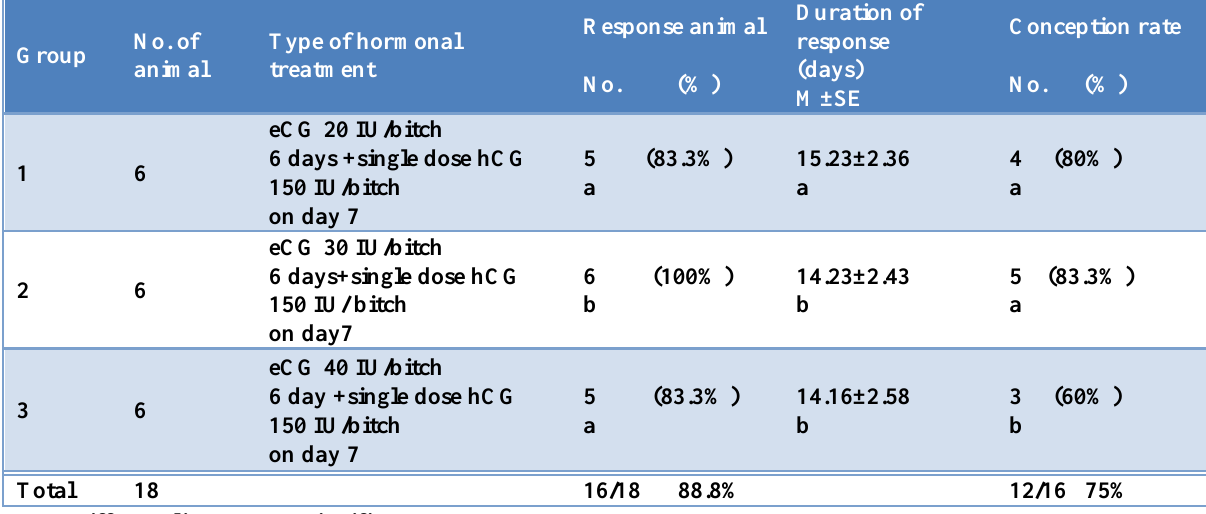
* Different litters mean significant P<0.01 Table, 2: Reveals the effect of treatment on nature of parturition, number and viability of newborns.